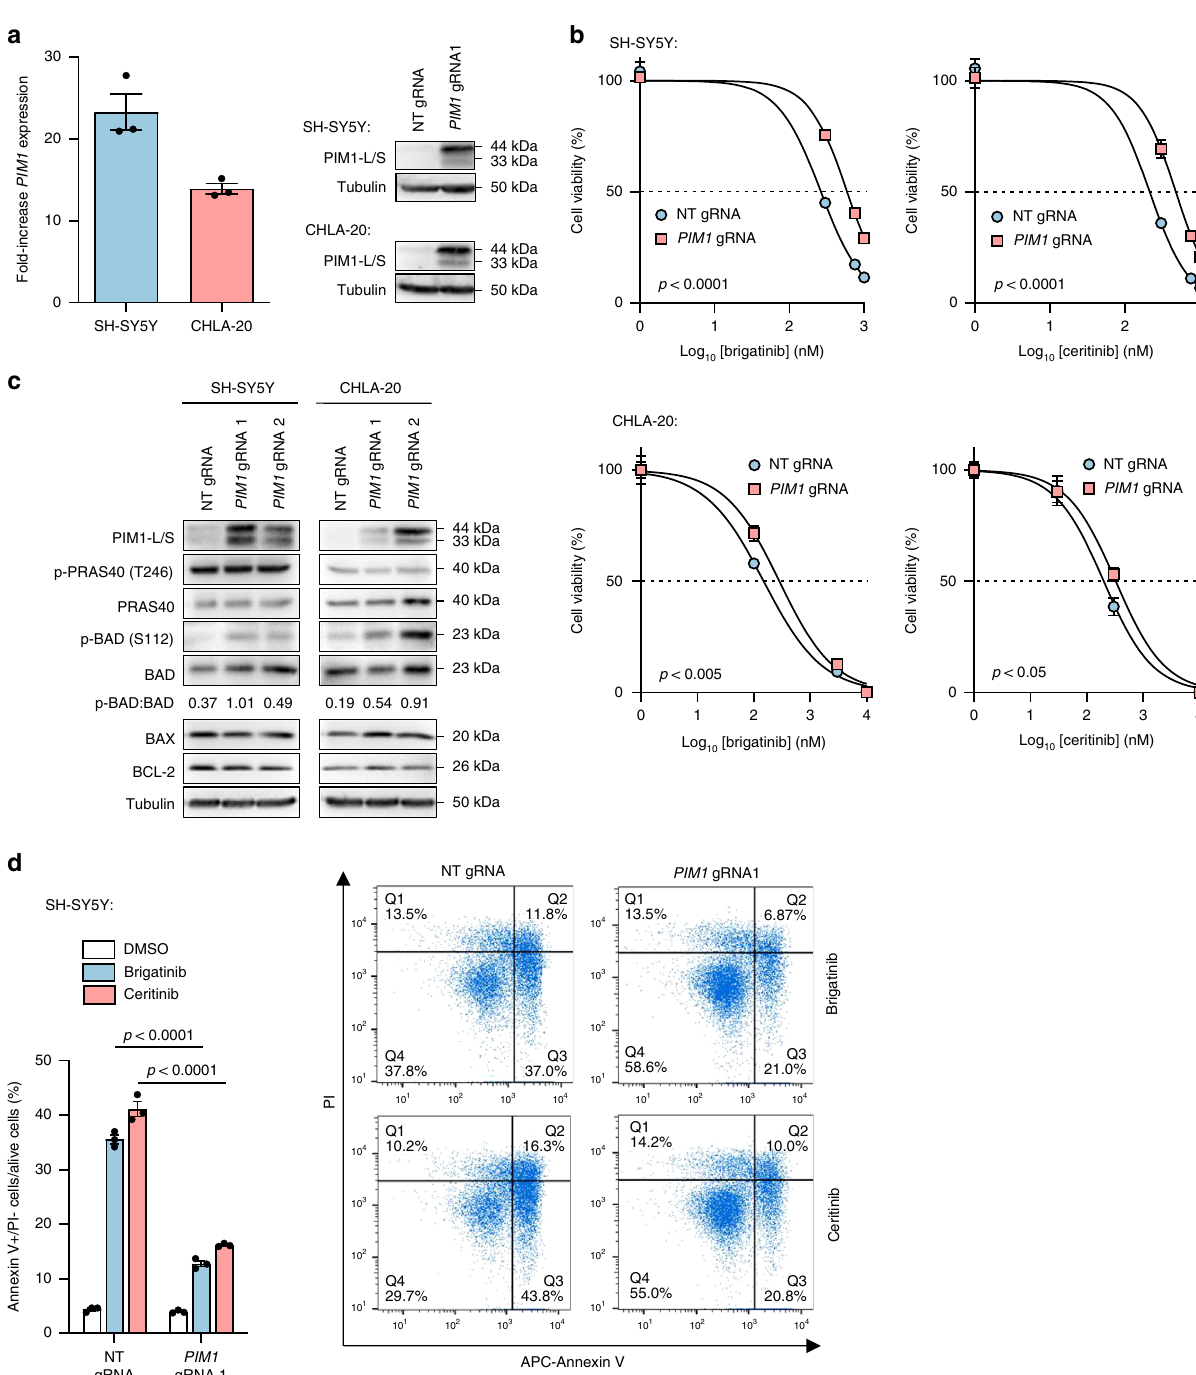
Fig. 2 PIM1 inhibits apoptosis through phosphorylation of BAD. a Expression of PIM1 in SH-SY5Y or CHLA-20 cells transduced with non-targeting (NT) or PIM1 -targeting gRNA molecules, by RT-qPCR and immunoblot. RT-qPCR data were normalized to cells treated with non-targeting gRNA and show means ± s.d. of triplicate experiments. b 72-h dose – response assays of brigatinib or ceritinib-exposed SH-SY5Y or CHLA-20 cells transduced with NT or PIM1 - targeting gRNA. Data points represent means ± s.d. of triplicate experiments. ED 50 values were compared by an unpaired Student ’ s t -test. c Immunoblot of known PIM1 targets and apoptotic mediators in SH-SY5Y and CHLA-20 cells transduced with NT- or PIM1 -targeting gRNA, the latter leading to PIM1 overexpression. Data are representative of three independent experiments. Numbers below the blot represent the densitometric measurement of pBAD levels normalized to BAD. d Percentage of apoptotic (annexin V + /PI-) PIM1 -overexpressing SH-SY5Y cells after 48-h of treatment with 1 µ M brigatinib or ceritinib. Data points in the bar chart show means ± s.d. of triplicate experiments. p -values were calculated using an unpaired Student ’ s t -test. Source data for this fi gure are provided as a Source Data fi